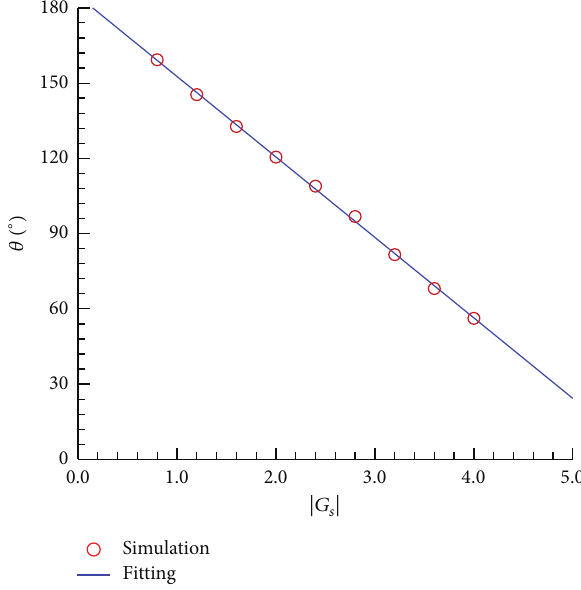
Figure 2: The relationship between intrinsic contact angle and adsorption